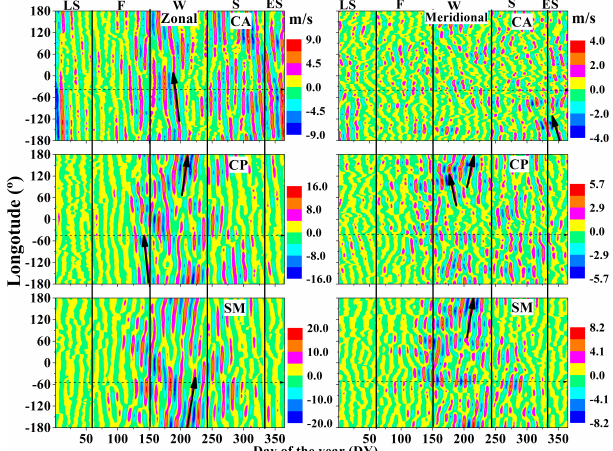
Figure 7. Same as Fig. 6, but here it is for the meridional